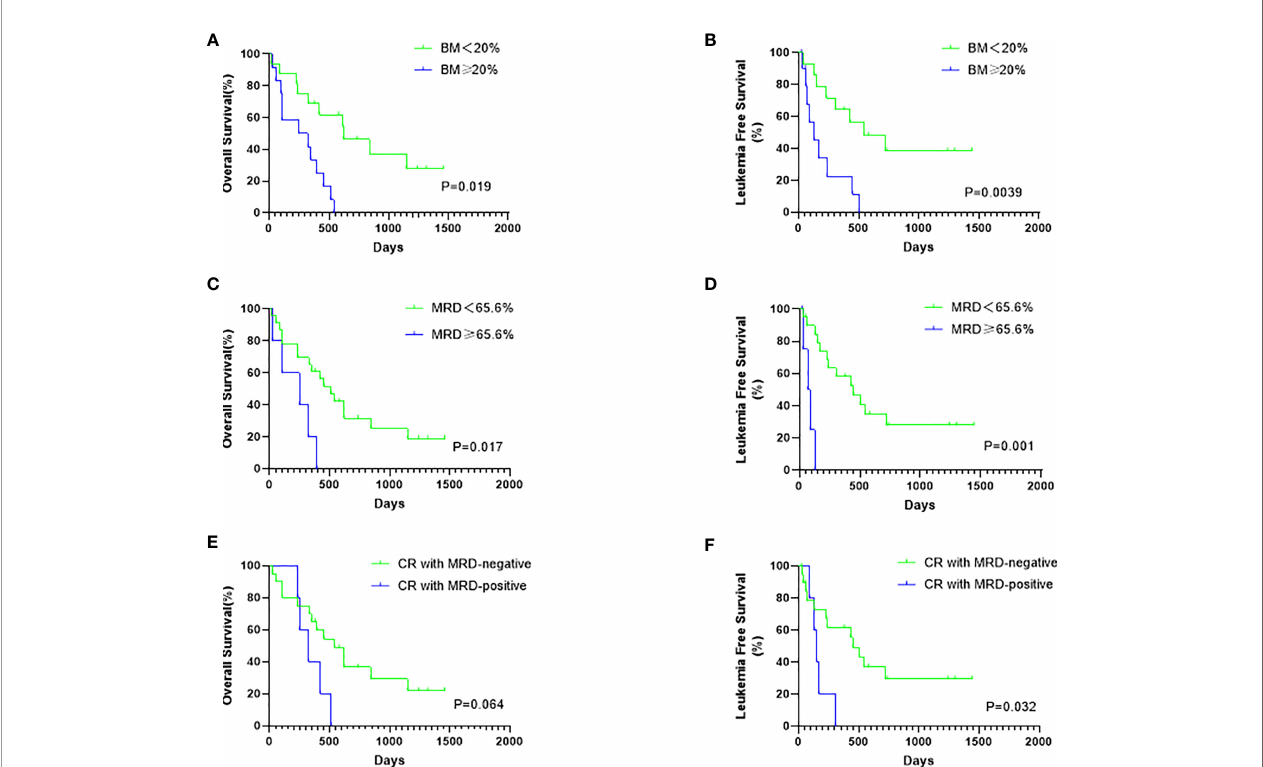
FIGURE 4 | The in fl uence of disease burden at infusion and MRD status after infusion on survival. (A) The OS rates of all patients according to the bone marrow (BM) blasts status at infusion. (B) The LFS rates of CR patients according to the BM blasts at infusion. (C) The OS rates of all patients according to the mRD status at infusion. (D) The LFS rates of CR patients according to the MRD status at infusion. (E) The OS rates of all 28 patients according to the MRD status after infusion (F) The LFS rates of 25 CR patients according to the MRD status after infusion.